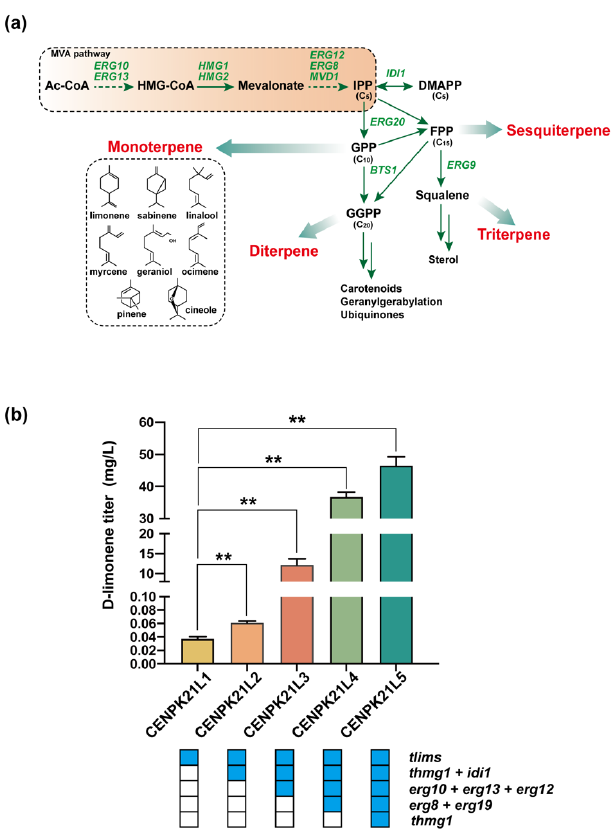
Figure 2. Stepwise increase in D-limonene production through the enhancement of the MVA pathway of monoterpene synthesis: ( a ) metabolic pathways for the production of various terpenes; and ( b ) D-limonene accumulation in engineered strains. Blue boxes represent gene overexpression. The limonene titer was only 53.14 µg/L when only the tHMG1 and IDI genes were strengthened; reached 12.18 mg/L after further strengthening ERG10 , ERG13 , and ERG12 ; and reached 36.77 mg/L after all seven genes of the MVA pathway were enhanced. After another tHMG1 copy was added, the limonene titers reached 46.96 mg/L (Statistical significance is indicated as ** for p < 0.01).